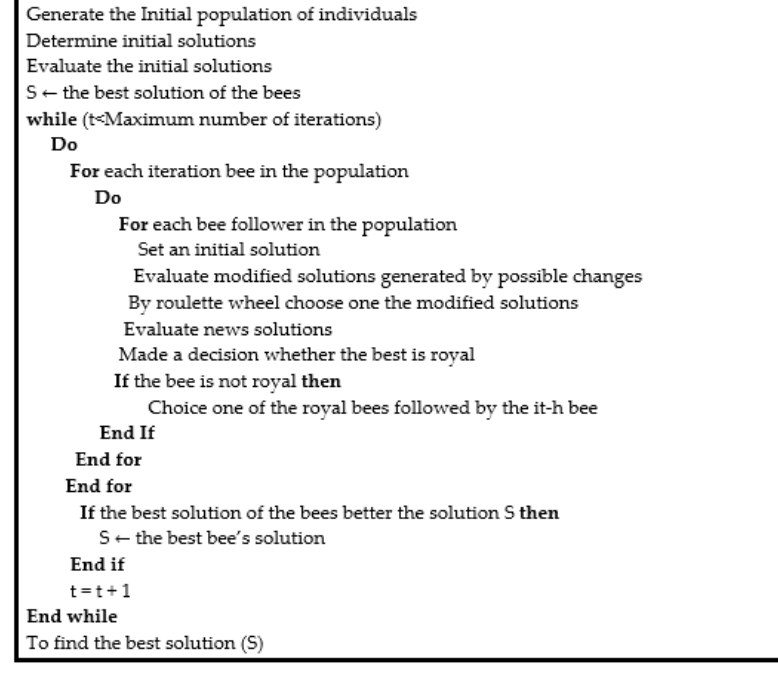
Figure 9. Bee colony optimization.